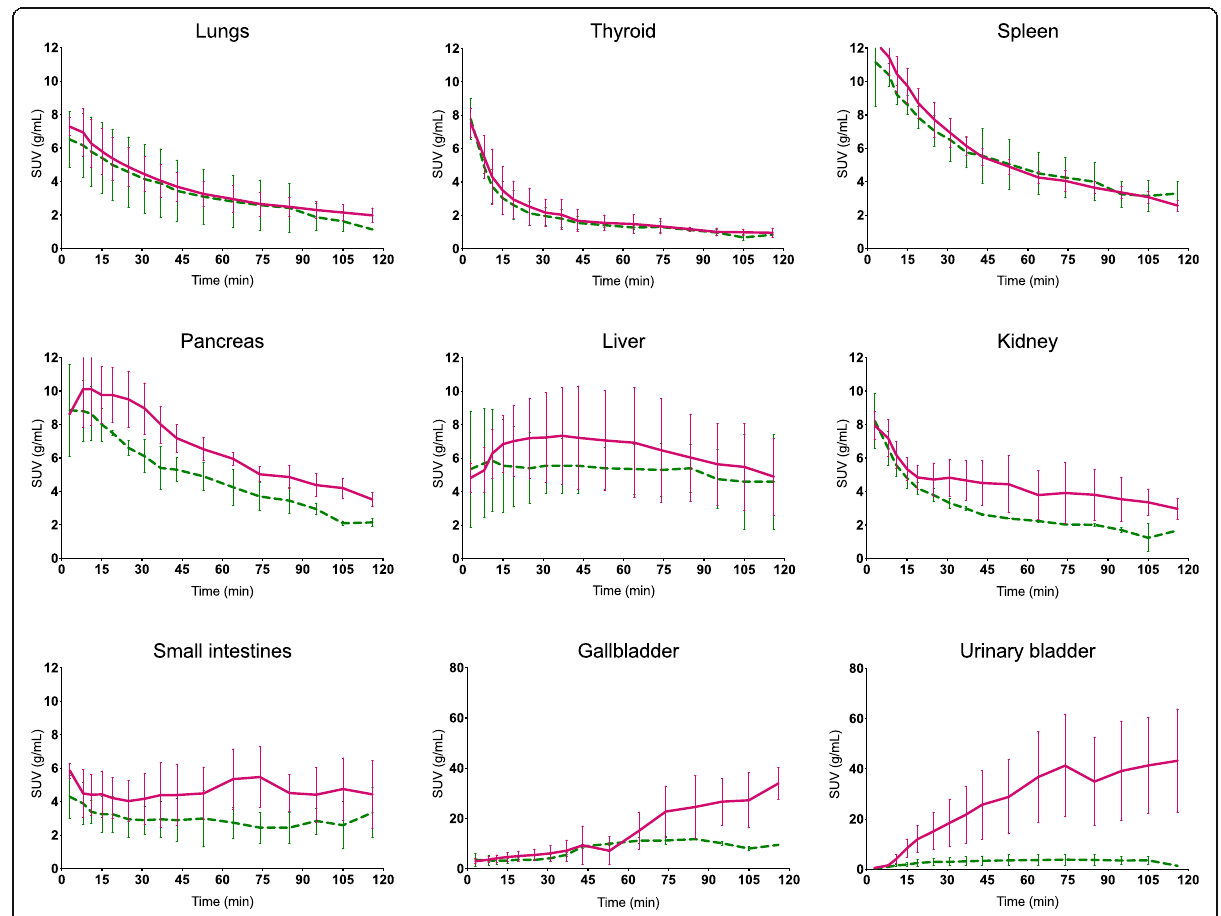
Fig. 2 Standard uptake value (SUV) curves for selected organ VOIs. Full line (pink) denotes 11 C-Cimbi-36 and dotted line (green) denotes 11 C-Cimbi-36_5. Note the different scale of SUV curves for the gallbladder and urinary bladder. Error bars represent standard